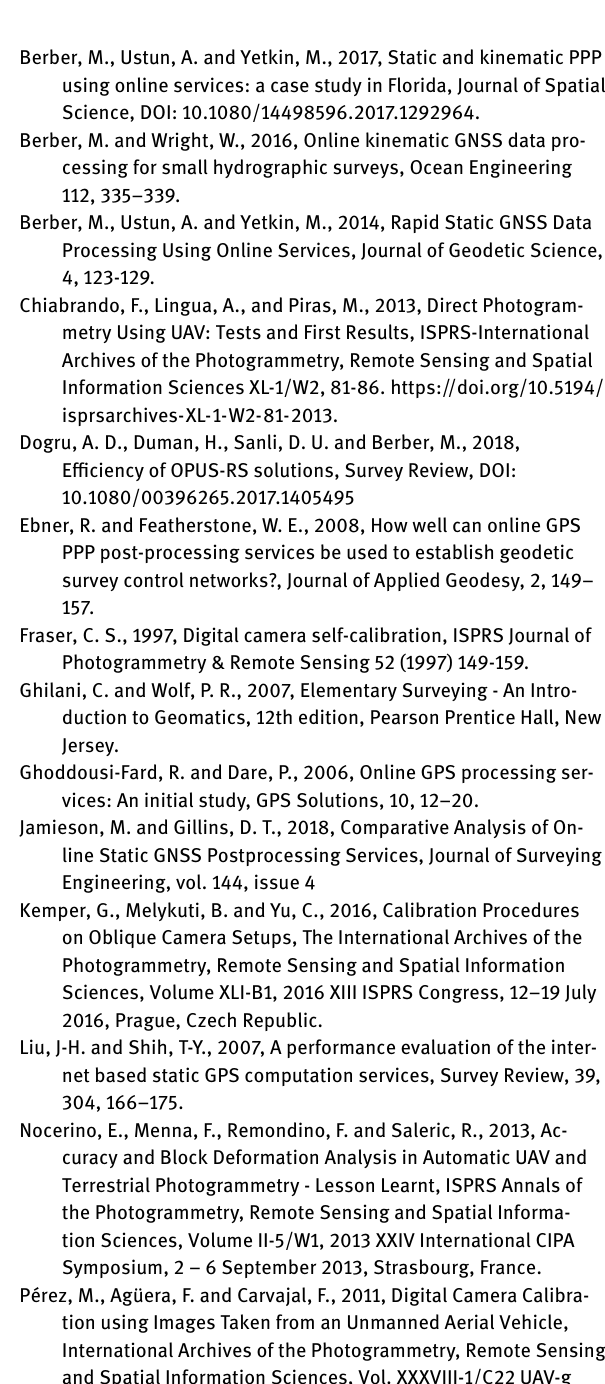
Horizontal Coordinates Vertical Coordinates Precision Accuracy Precision RTKLIB cm dm CSRS-PPP cm dm cm dm GAPS dm m dm m APPS dm m dm